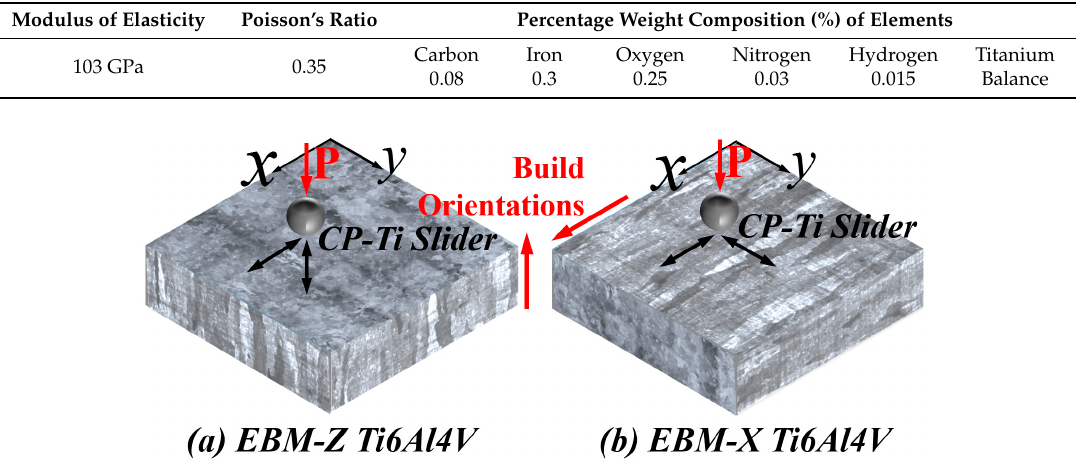
Table 2. Mechanical properties of commercially pure (CP) grade-2 titanium spheres. Modulus of Elasticity